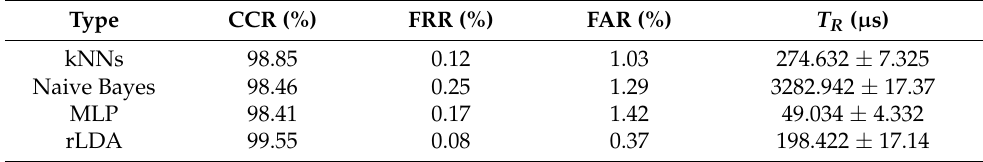
Table 10. Classification results for ensemble of homogeneous classifiers, weighted